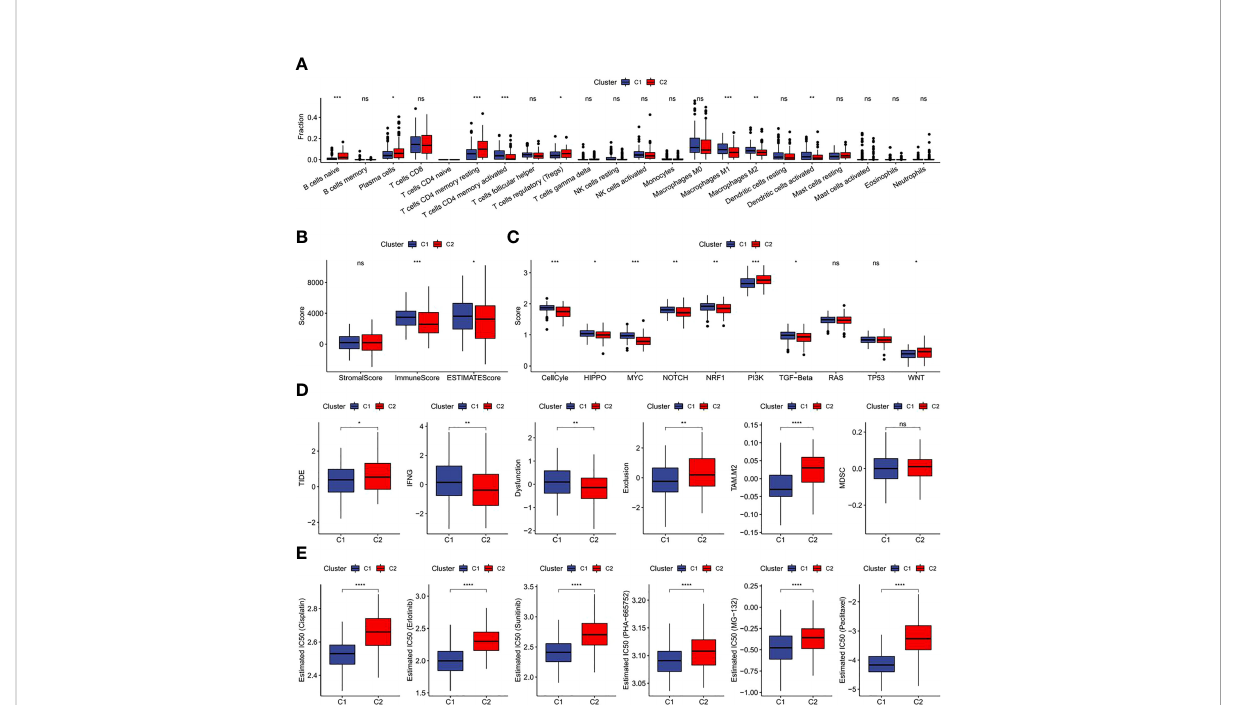
FIGURE 7 Immunological characteristics, immunotherapy, chemotherapy and target therapy responses of two fatty acid-related subtypes (A) Difference of 22 immune cell scores between different molecular subtypes in the TCGA cohort; (B) Difference of ESTIMATE immune in fi ltration between different molecular subtypes in the TCGA cohort; (C) Difference in the score of 10 pathways related to tumor abnormality between different subgroups in the TCGA cohort; (D) Difference of TIDE analysis results between different groups in the TCGA cohort; (E) The box plots of the estimated IC50 for drug in TCGA-CECS. *p<0.05,**p<0.01,***p<0.001, ****p<0.0001, ns, P>0.05.